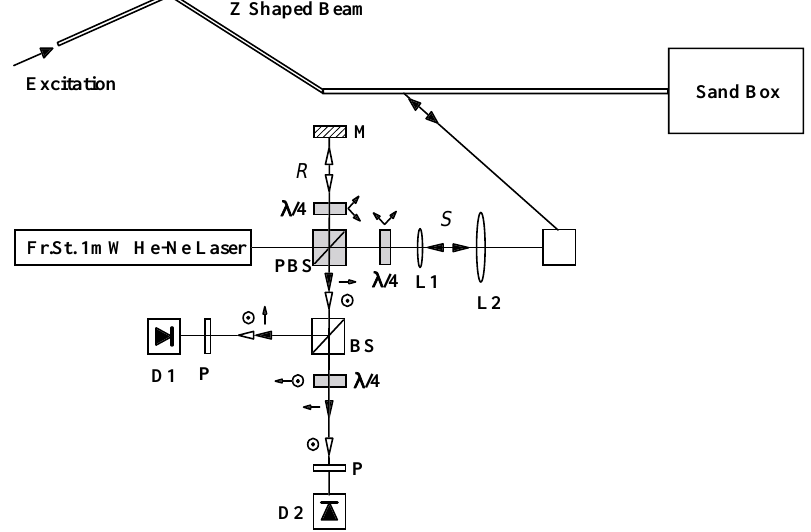
Fig. 2. Simplified scheme of the homodyne